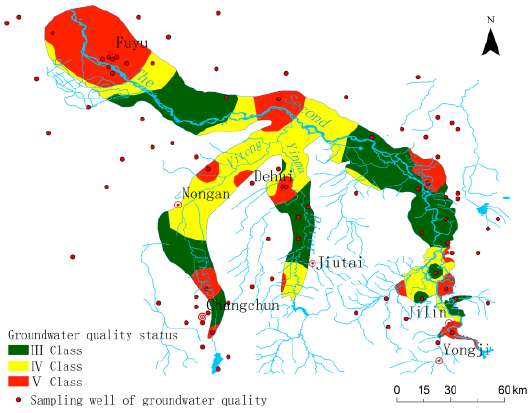
Figure 10. Groundwater quality status.